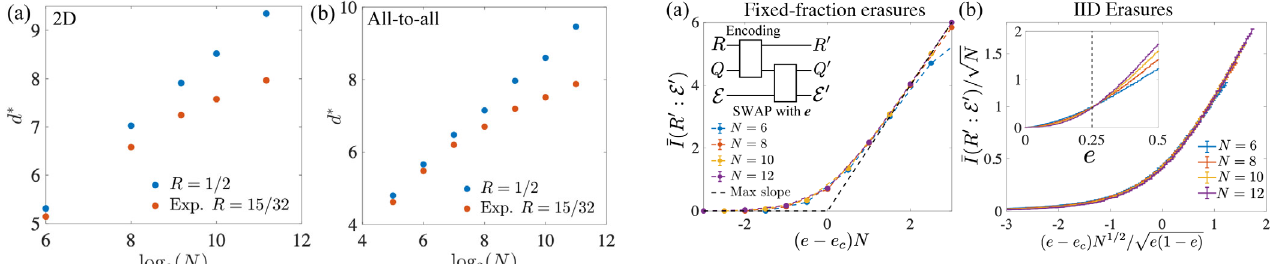
FIG. 7. (a) Interpolated depth d (cid:4) to reach 50% failure proba- bility for a 2D random Clifford circuit with periodic boundary conditions vs log-system size. All logical operators are turned into gauge degrees of freedom during expurgation. We remove the small amount of N= 32 to aid in extracting the scaling vs log 2 N to large sizes and small depths. We take an erasure fraction n =N ¼ 1 = 8 for both the expurgation algorithm and the calcu- e lation of the failure probability. (b) Same as panel (a), but for an all-to-all circuit in which N= 2 pairs of sites are randomly selected to apply a two-qubit gate for each unit of depth. Each two-qubit gate in both geometries is a random Clifford gate.